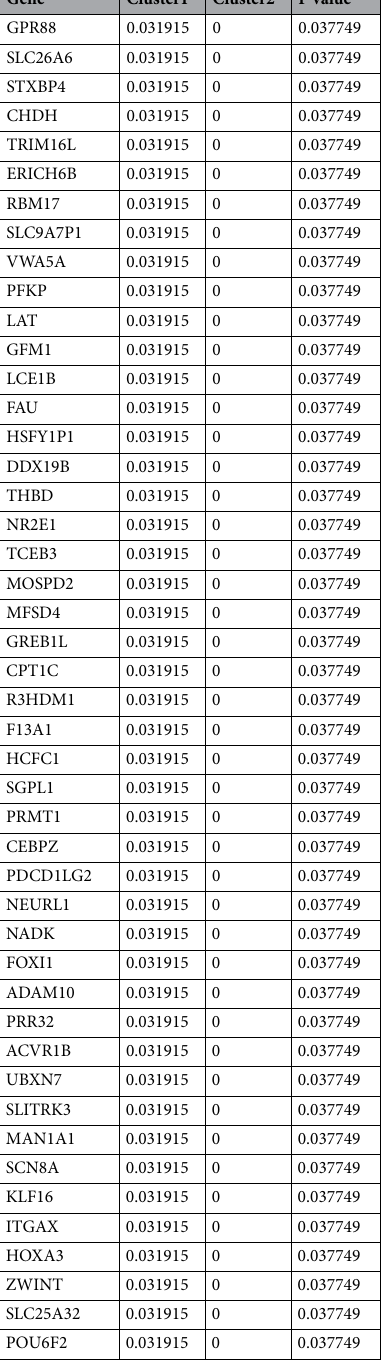
Table 2. Mutation distribution of high-frequency mutation genes in the two molecular